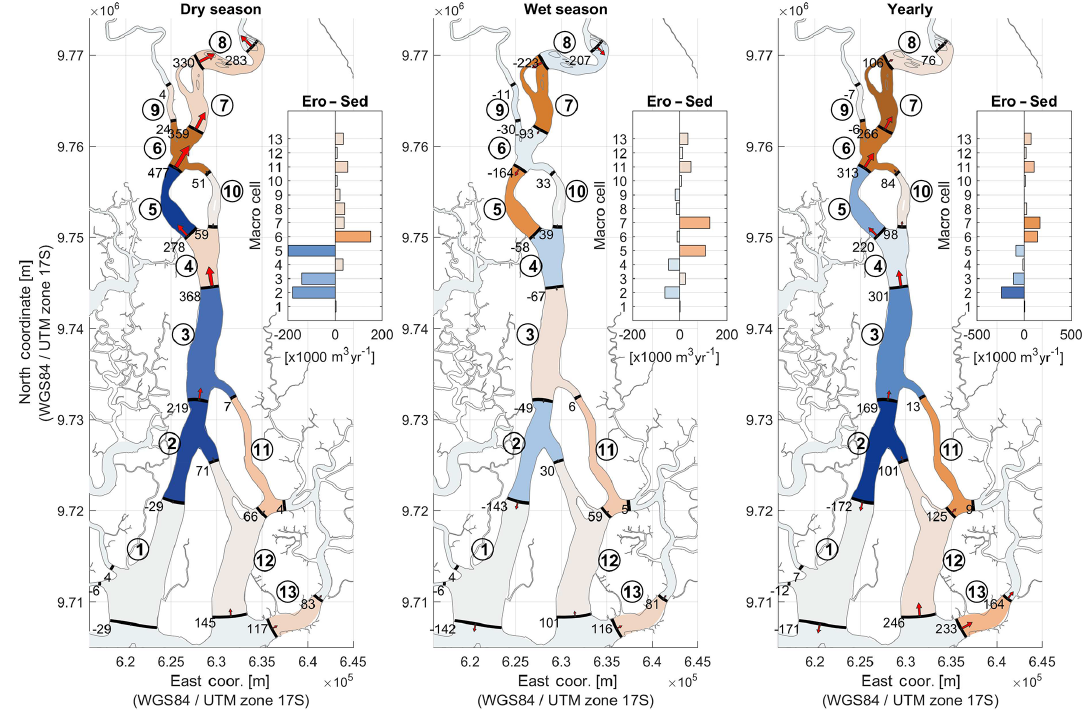
Figure 13. Sediment balance computed yearly and seasonally for sea level rise (Case